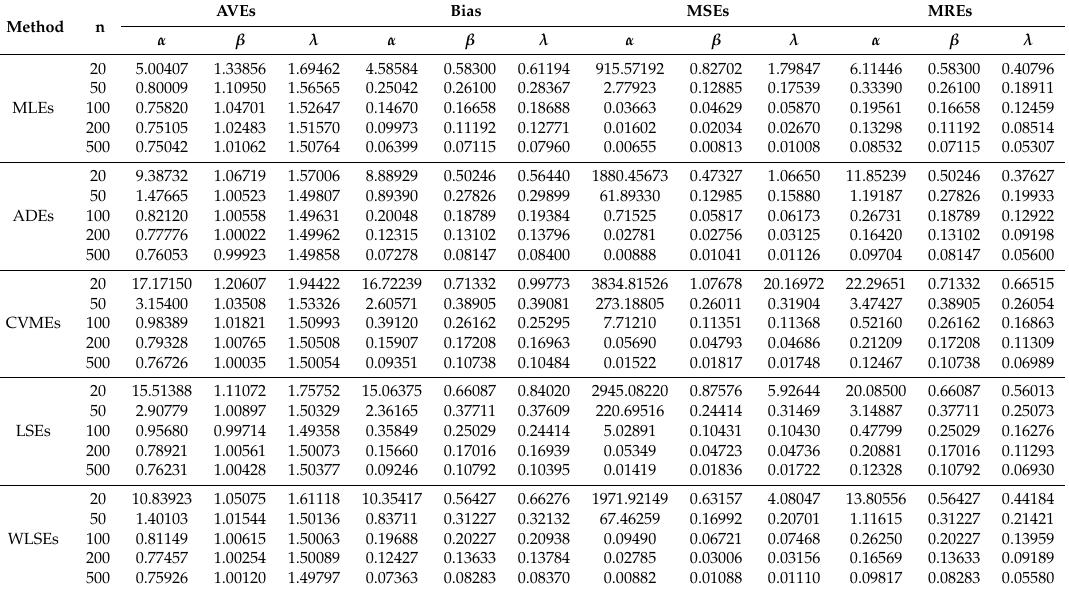
Table 3. Simulation values of the AVEs, biases, MSEs, and MREs for ( α = 0.75, β = 1, λ = 1.5 ) . Method